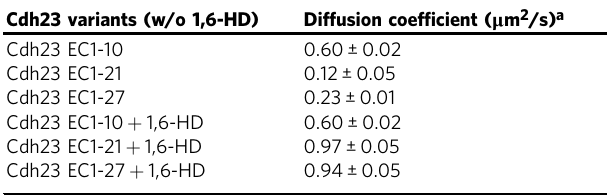
Table 2 Diffusion coef fi cients measured for the clusters of Cdh23 variants (with/without 1,6-HD) anchored to GUV